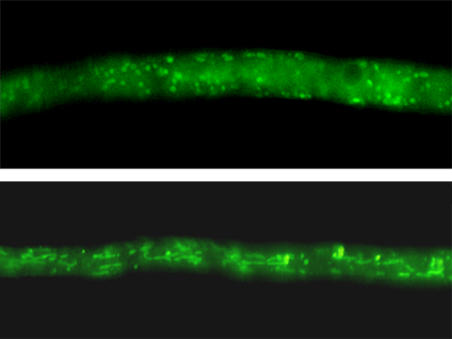
Chemicals from plant roots change the shape (from spherical, top, to threadlike, bottom) and increase the density of mitochondria in fungus, setting the stage for a symbiotic partnership.